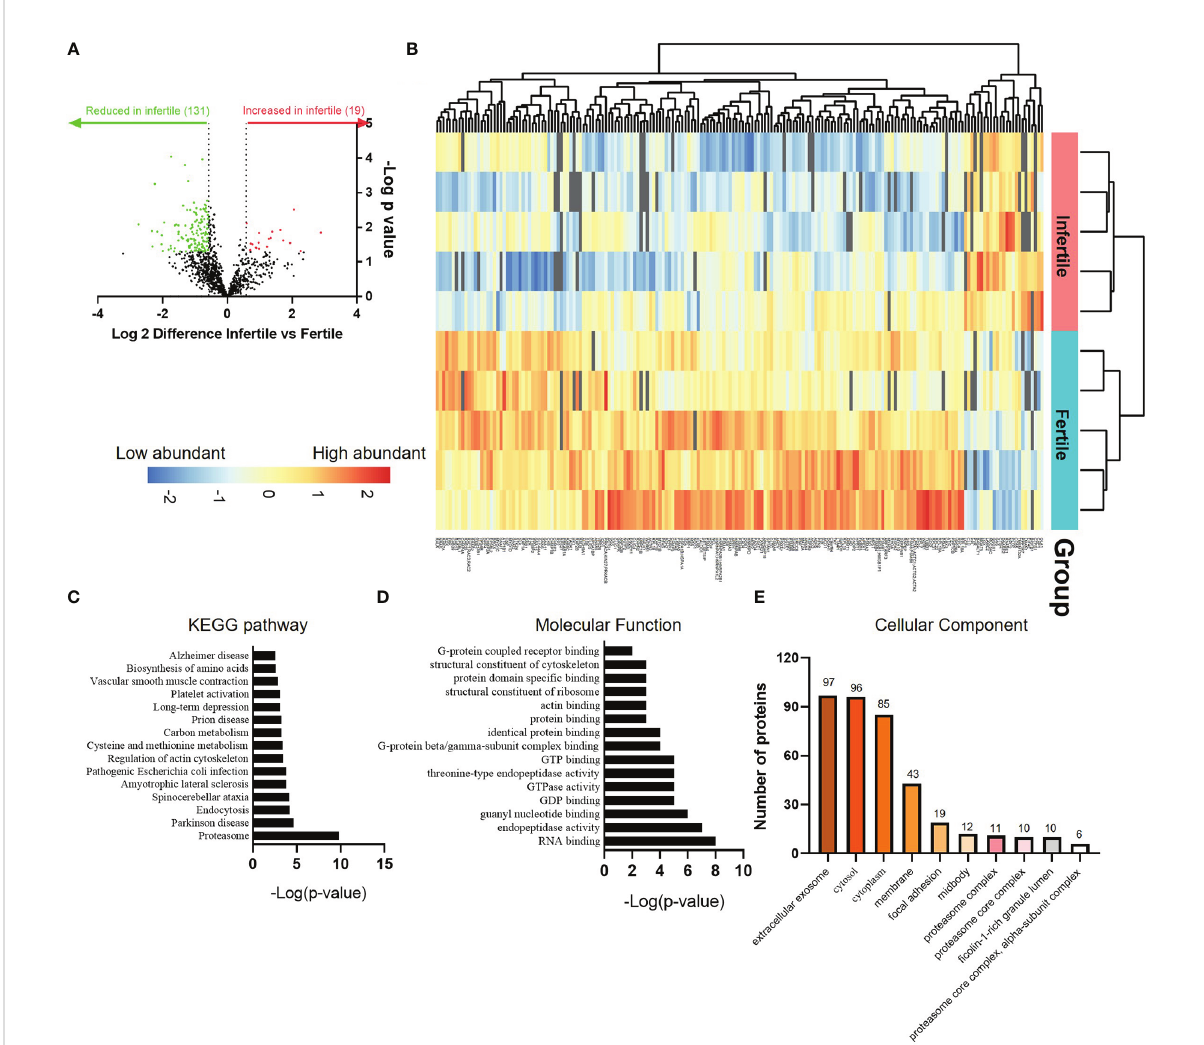
FIGURE 5 Proteomic comparison of fertile and infertile IOF after E2+MPA+cAMP treatment. (A) Volcano plot depicting fold changes associated with differentially expressed proteins between fertile and infertile IOF. Thresholds of ± ≥ 1.5-fold change ( P < 0.05) were implemented. (B) Heat map of the signi fi cantly differentially expressed proteins between fertile and infertile IOF with at least 1.5-fold difference. Top 15 (C) KEGG pathways, (D) GO molecular functions and (E) cellular components (ranked by -Log[p-value]) assigned to proteins that are signi fi cantly lower in infertile IOF with at least 1.5-fold difference compared to fertile (also see Supplemental Tables 3-6). (n=5 biological replicates). IOF, Intra-organoid fl